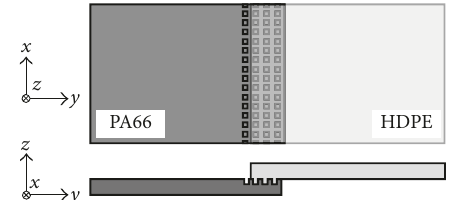
Figure 6: Loads on a single lap test specimen during the test.